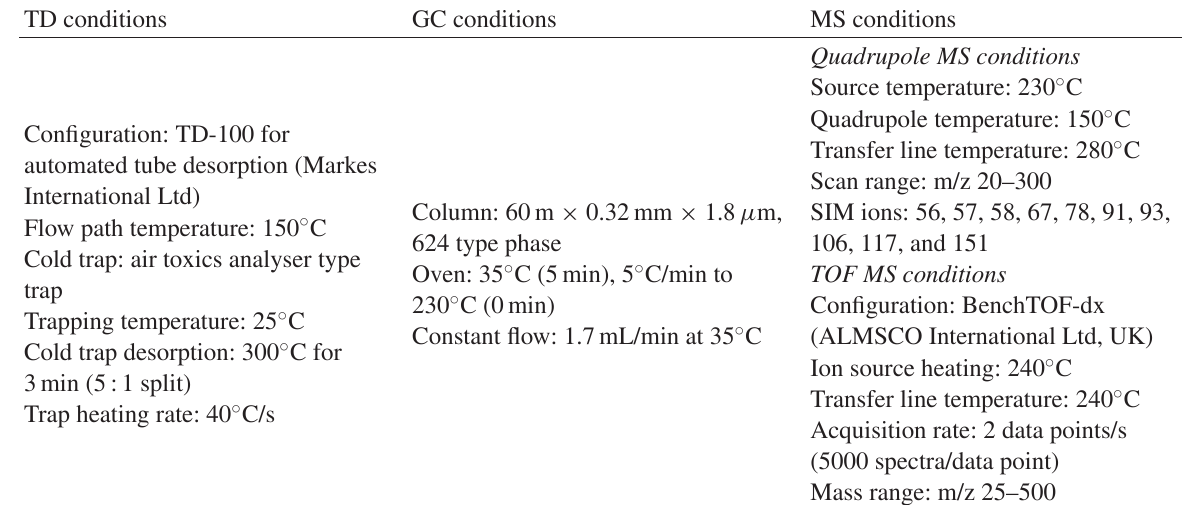
FIGURE 12: Extracted-ion 117 for carbon tetrachloride from a 200 mL sample of semi-rural ambient air, analysed by TD-GC/MS (TD-100, Markes International Ltd), using a quadrupole mass spectrometer (full scan, blue; SIM, red) and a TOF mass spectrometer (black—BenchTOF-dx ALMSCO International Ltd, UK). Signal-to-noise ratios are shown for each detection method. Note that quadrupole in full scan did not detect this compound. Method conditions are shown in Table 11. TABLE 11: Sampling and analytical